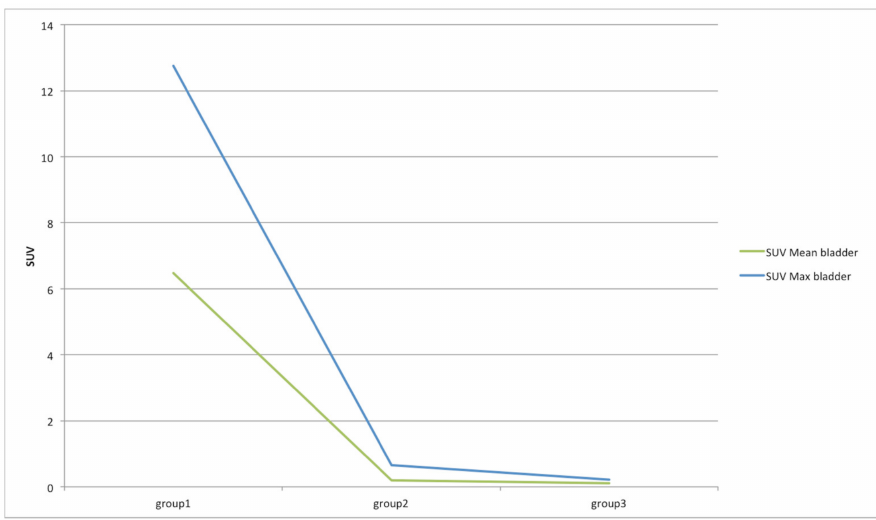
Figure 12. SUV max and SUV mean variations among groups in the bladder